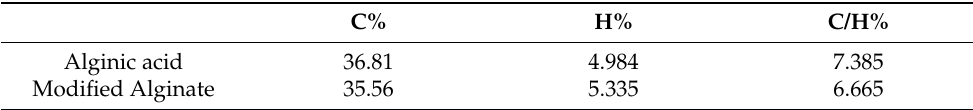
Table 1. Elemental analysis of alginate and its aromatic derivative.